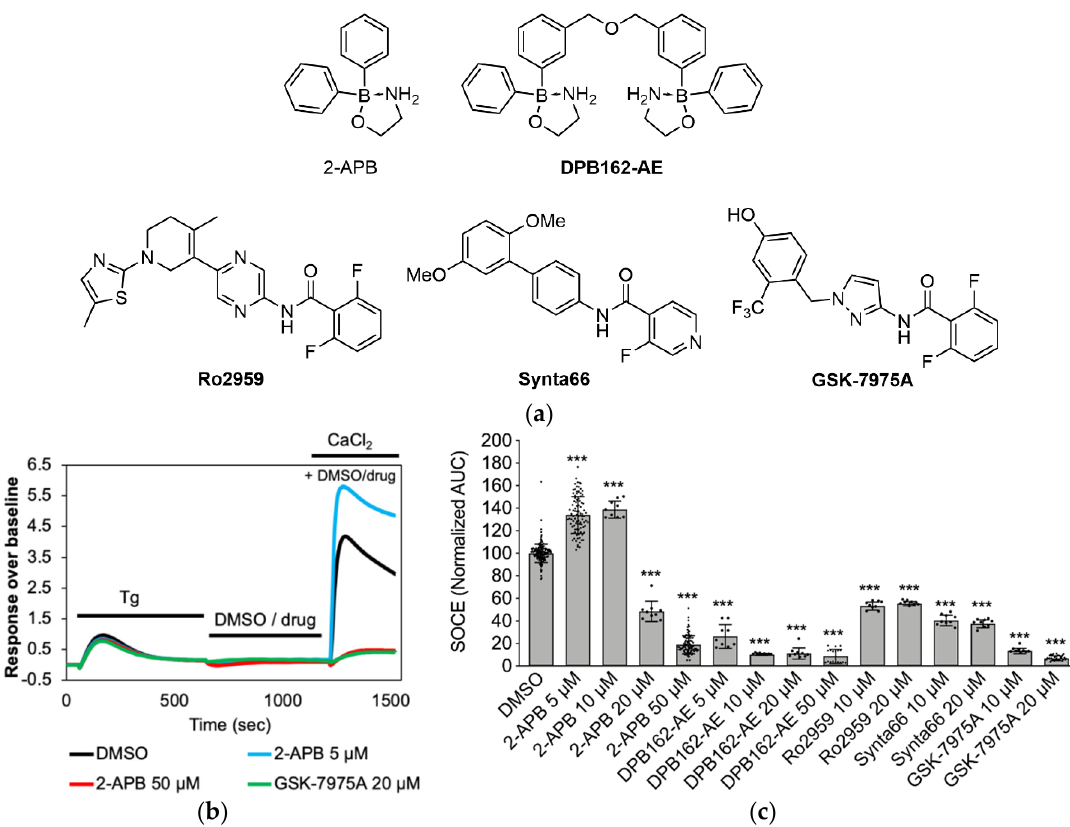
Figure 1. Pharmacological characterization of store-operated calcium entry (SOCE) in MDA-MB-231 cells by fluorometric imaging plate reader (FLIPR) assay. ( a ) Structures of known SOCE inhibitors used in the validation of the assay. ( b ) Recorded intracellular calcium signal over the course of the assay. Black bars above traces indicate duration of applications. MDA-MB-231 cells were incubated with thapsigargin (Tg, 1 µM, 10 min) in nominal calcium-free (NCF) buffer, followed by DMSO (negative control) or drug application (in NCF) for 10 min and finally, addition of 2 mM extracellular CaCl 2 . Note how low concentration (5 µM) of 2-APB enhanced SOCE (blue trace) whereas at high concentration (50 µM) SOCE is blocked (red trace). ( c ) Quantification of calcium influx after CaCl 2 application (area under the curve (AUC)), normalized to DMSO control ( n ≥ 9 for all data points). Data shown are mean ± SD. Statistical significance compared to DMSO control is indicated as “***” for p ≤ 0.001.